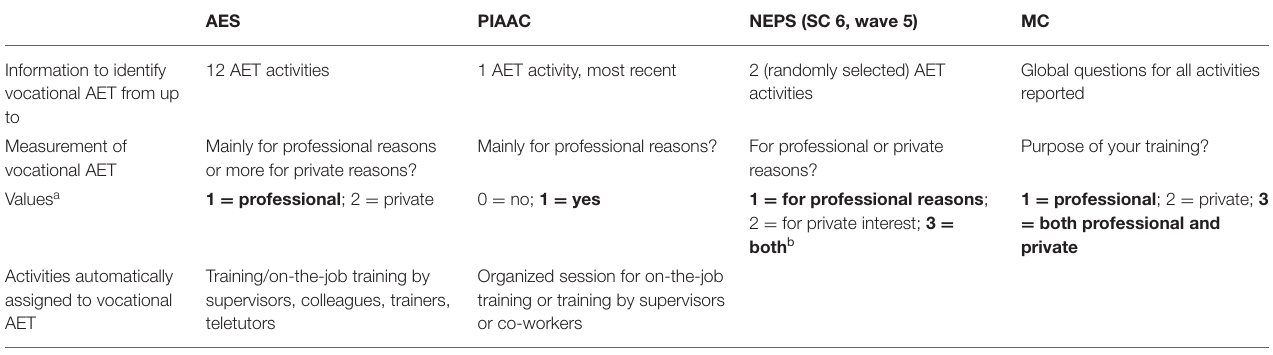
TABLE 3 | Operationalization of vocational AET in the AES, PIAAC, NEPS, and